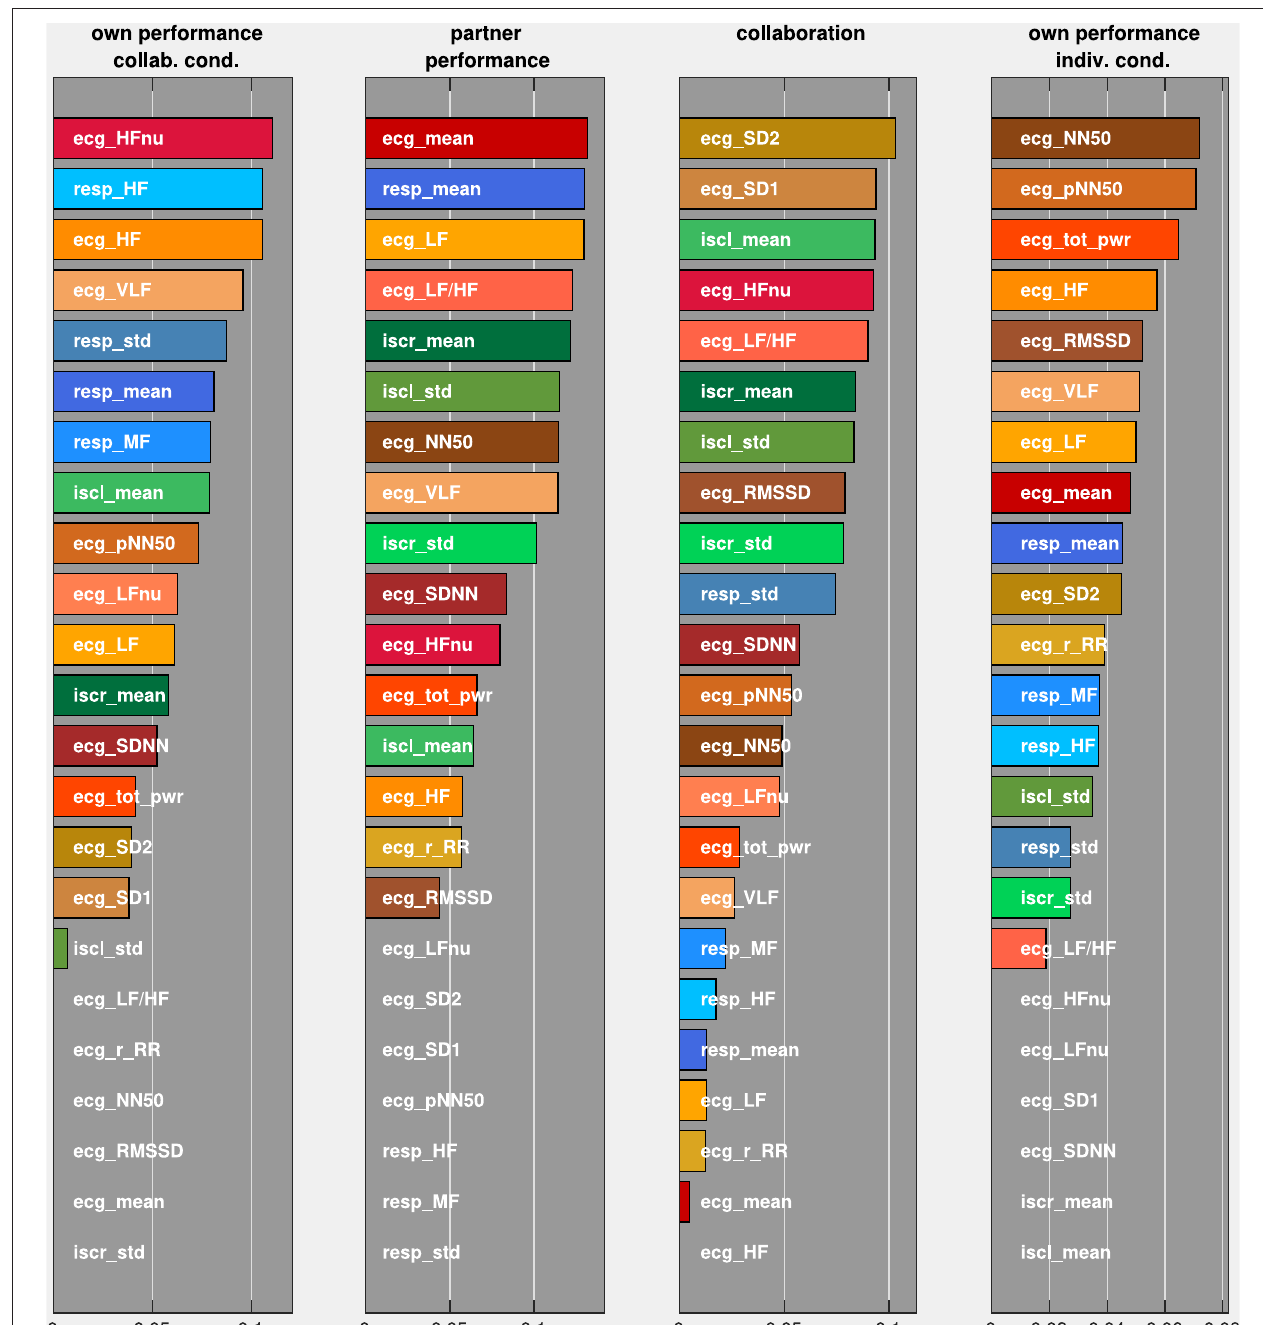
FIGURE 9 | Average decrease of F1-scores (on the abscissa) under permutations of individual predictors (on the ordinate). Predictors were ordered according to their associated F1-score change.